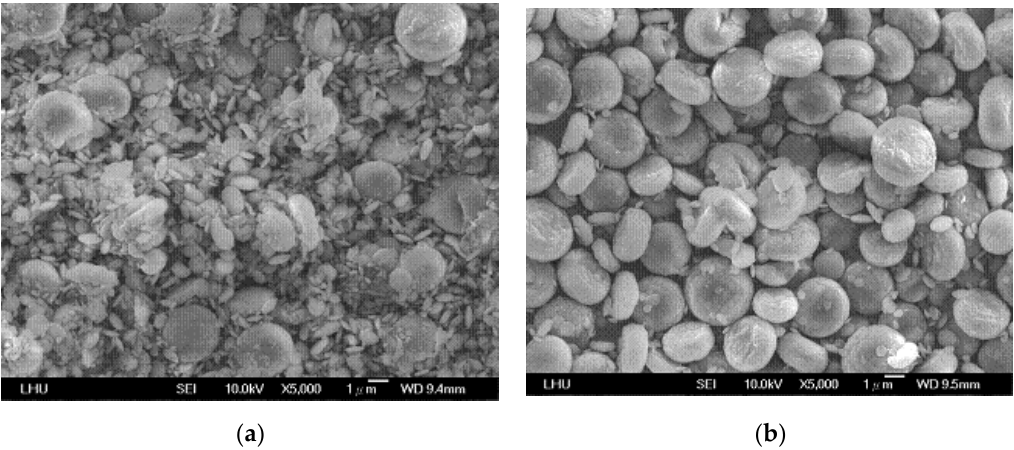
Figure 6. Effects of pH on the morphology and crystal size of vaterite (y 1 = 10%, Q g = 4L/min). ( a ) pH = 10 (d p = 1.41 μ m) (No.5); ( b ) pH = 11 (d p = 1.83 μ m) (No. 6).